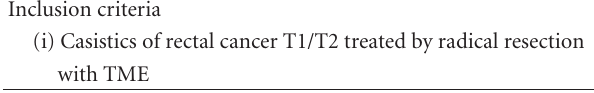
Table 1: Inclusion and exclusion criteria for study selection. Inclusion criteria